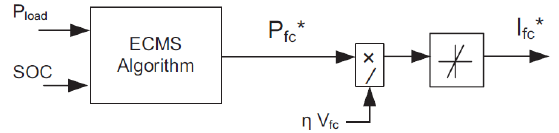
Figure 4. The block diagram of the equivalent fuel consumption minimization strategy (ECMS).